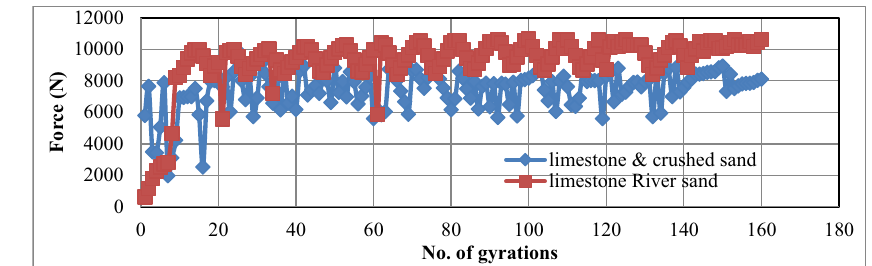
Figure 5: The measured force on the sample obtained from the modi fi ed gyratory apparatus using limestone as fi ller.